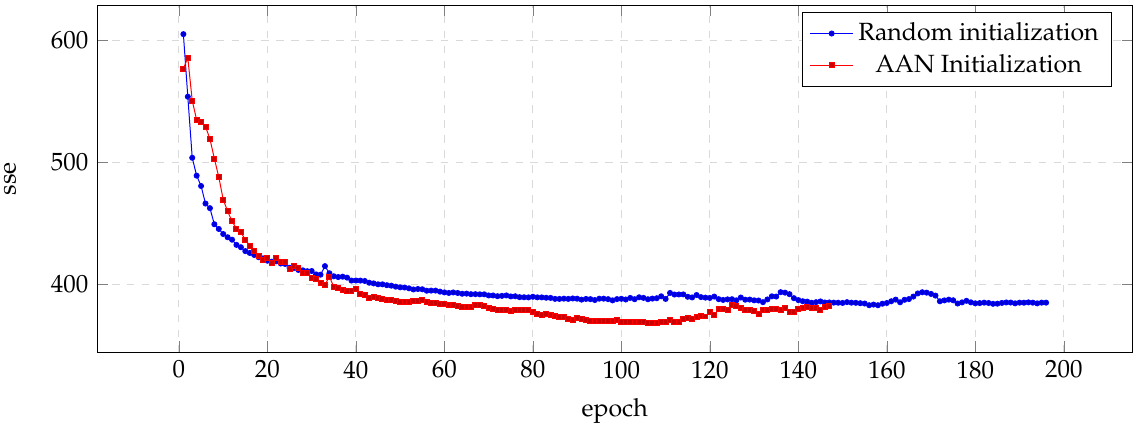
Figure 3. Evolution of the sse value for the validation set during the training process of the JMK voice.